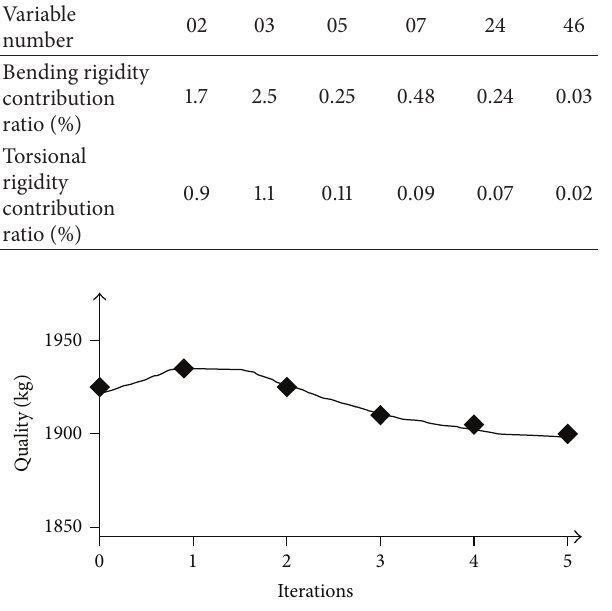
Figure 5: The simulation result of vehicle weight.